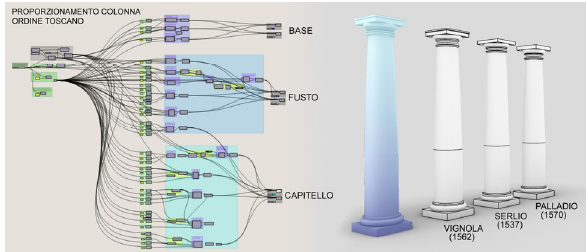
Figure 6. Parametric modeling for Architectural